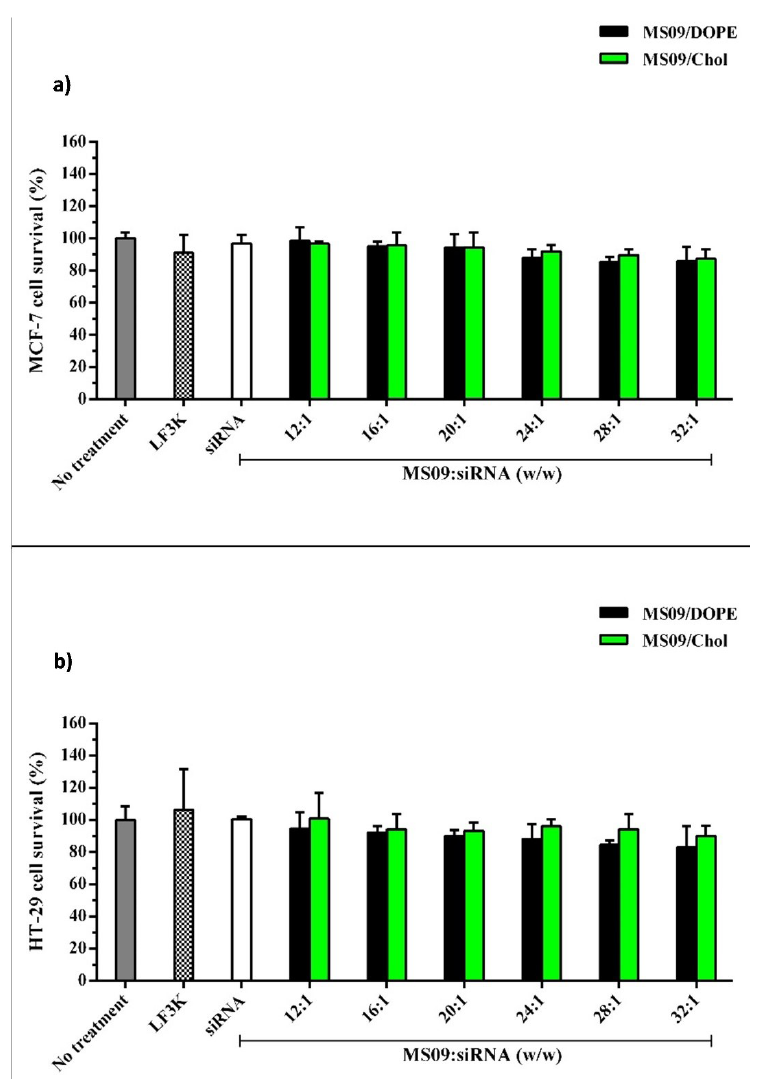
Figure 6. MTT viability assays with lipoplexes containing 14 nM siRNA. a ) MCF 7 and b ) HT-29 cells. Cells were exposed to lipoplexes for 48 h at 37 ° C in the presence of serum. Each column represents the mean ± SD ( n = 3). P > 0.05 vs. untreated cells and DOPE containing counterparts. LF3K denotes Lipofectamine ™